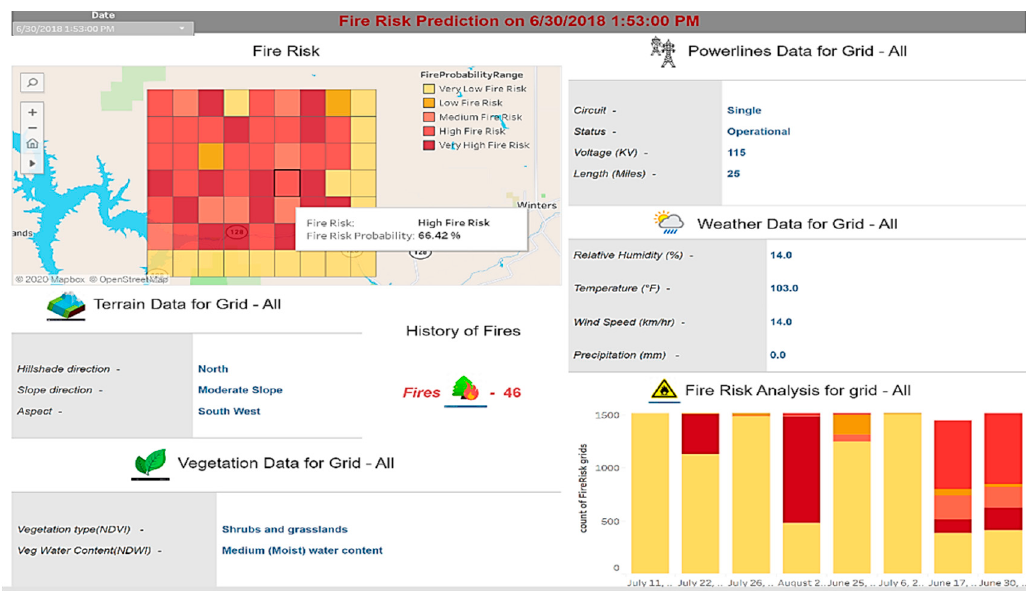
Figure 14. Fire Risk Prediction on 6/30/2018.